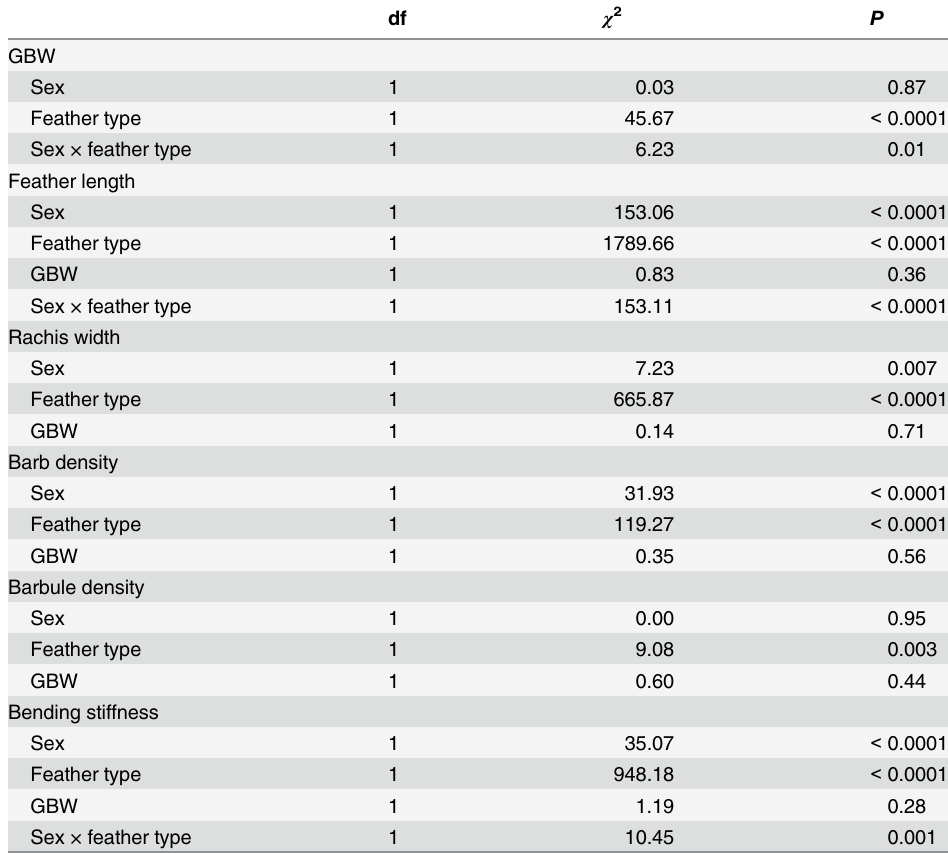
Table 2. Linear mixed-effects models of the relationship between quality traits and GBW of tail feath- ers (Ta5 and Ta6) of male and female barn swallows from the Romanian population. df χ 2